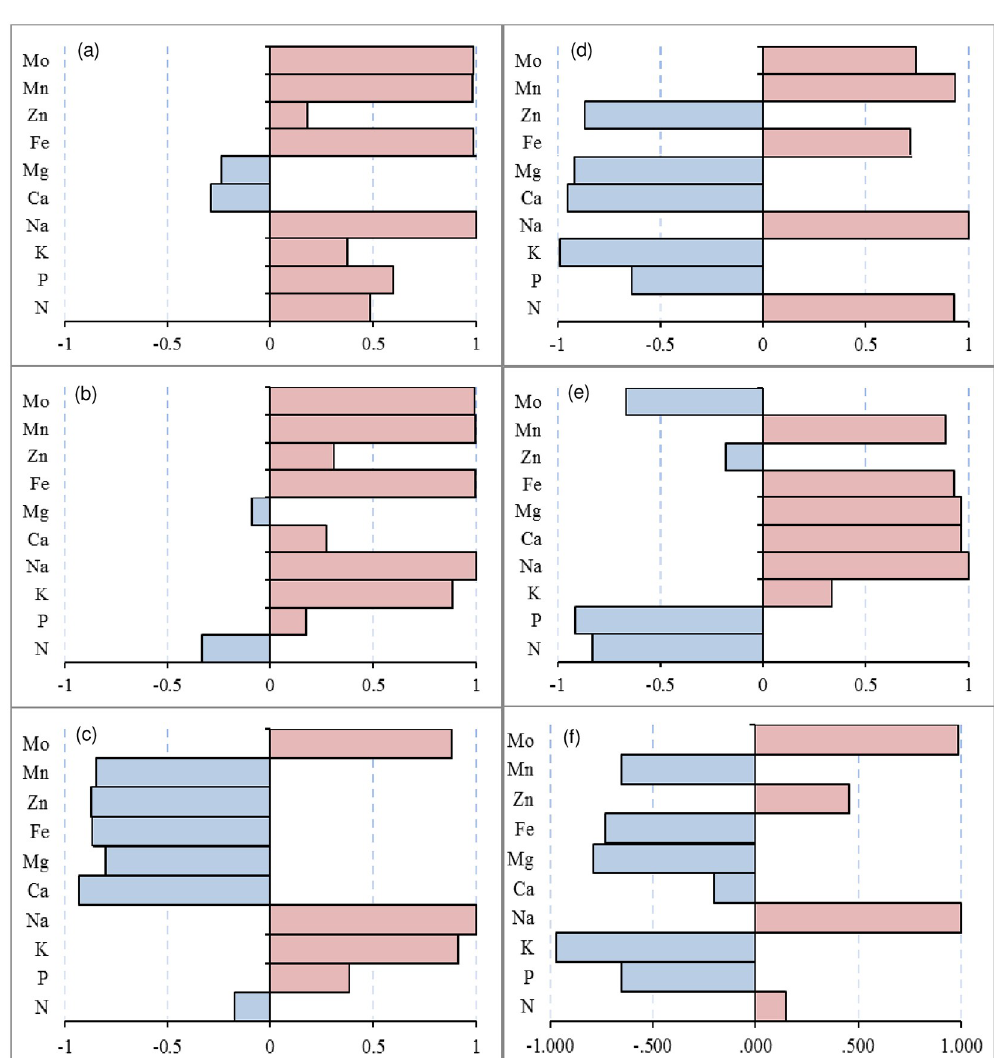
Fig 7. Correlation between the concentration of Na and other elements in leaves, stem, and root of two cotton varieties (salt-tolerant variety L24, salt-sensitive variety G1) under saline-alkaline stress. (a), (b), and (c) stand for the leaves, stem, and root of L24, respectively; (d), (e), and (f) stand for the leaves, stem, and root of G1,